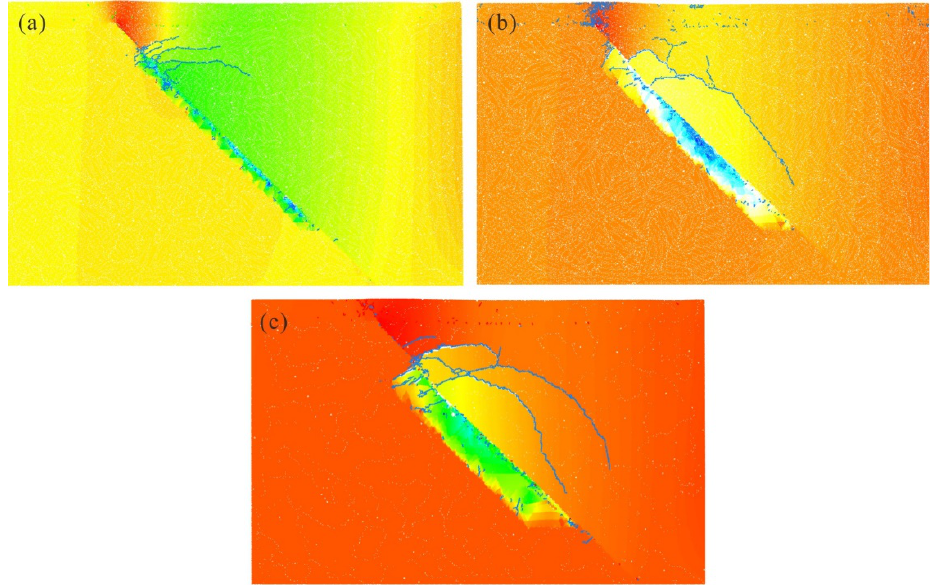
Figure 10. Failure modes for mining of an ore body with different thicknesses. ( a ) Thickness of 20 m; ( b ) thickness of 40 m; ( c ) thickness of 60 m.